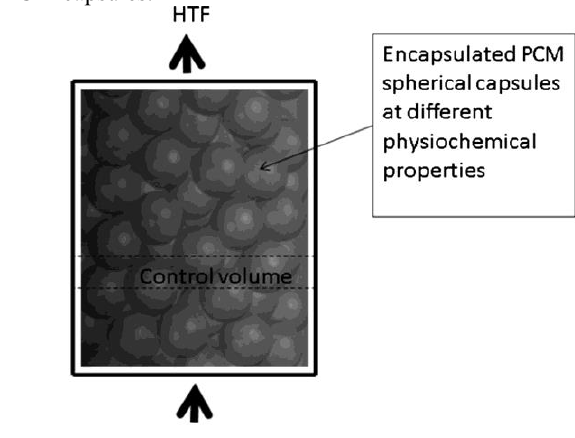
Figure 5 Schematics of the LTES system